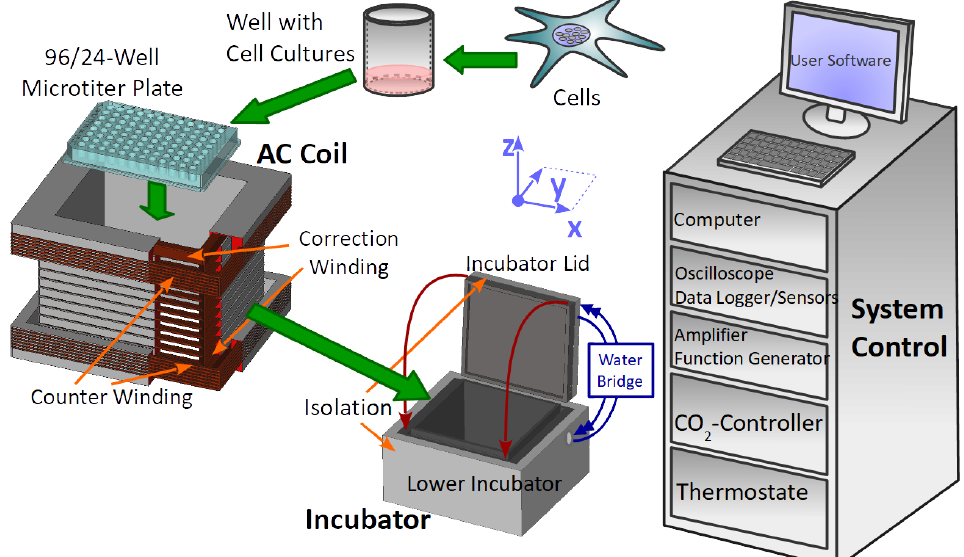
Figure 1. Experimental setup containing the biological sample in the microplate. The cell-culture plate fits into the rectangular coil which generates the AC magnetic field. Both culture plate and coil are placed in the incubator regulated by thermostat and CO 2 -controller. Atmospheric conditions in the incubator are logged with sensors. Function generator and amplifier generate the current for the coil. All active devices are connected and controlled by the system control computer, which provides a user interface to manage experimental settings and triggers the EMF exposure automatically. The inner part of the incubator housing (lower incubator and incubator lid) is surrounded by a styropor thermal isolation. The bottom part and the heated lid are connected via a water bridge. The coil has an inner winding including the correction winding and an outer part with a counter winding for far-field reduction. An oscilloscope allows the indirect measurement of the AC magnetic field by using a shunt and the B/I calibration of the coil. A summary of all devices is given in the Supplement, Table